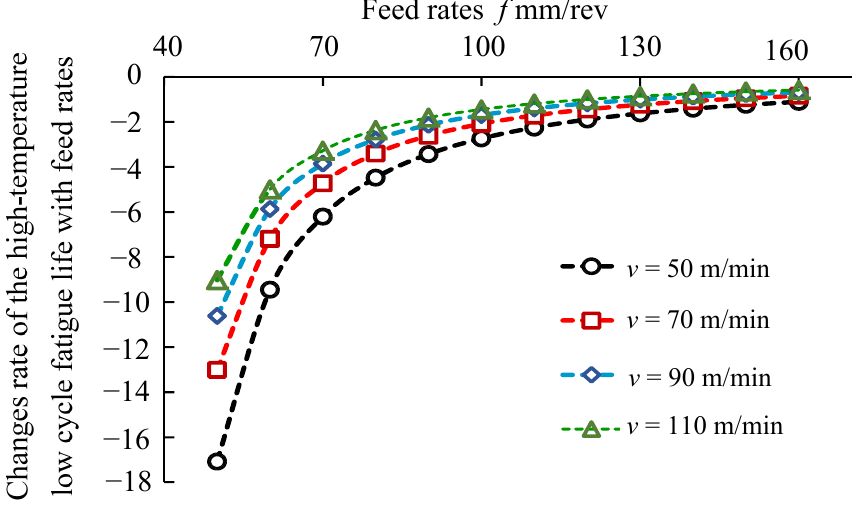
Figure 17. Sensitivity analysis of high-temperature low-cycle fatigue life to feed rates.